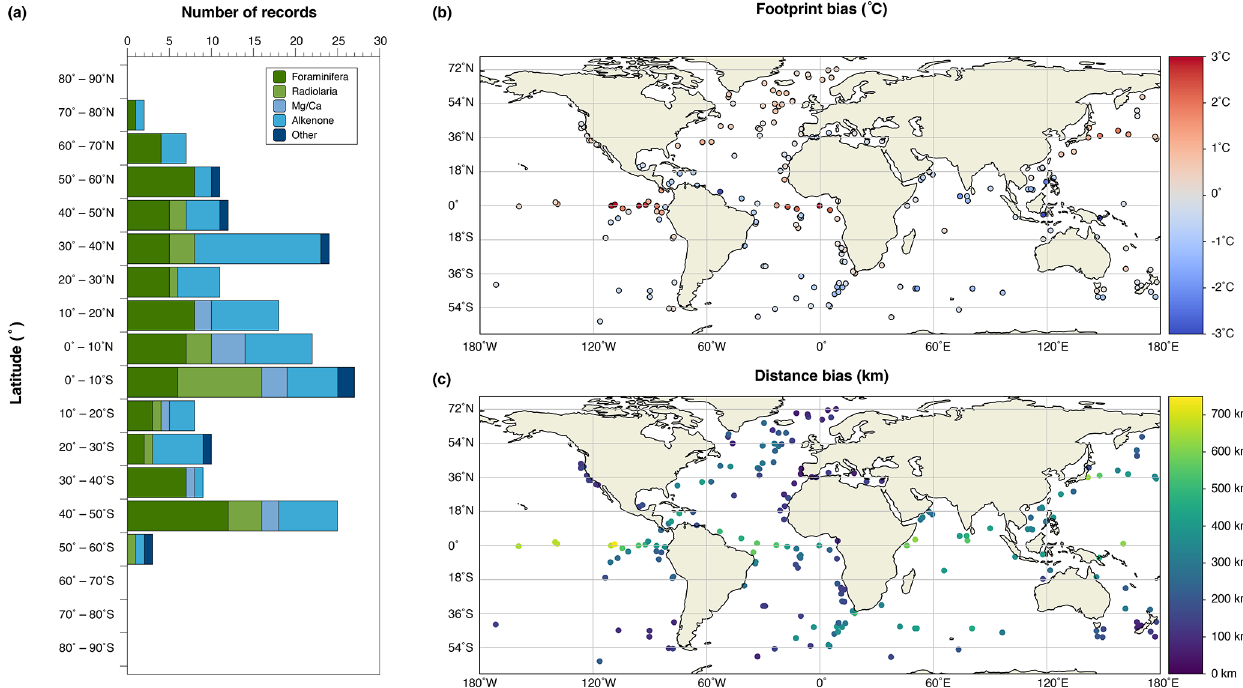
Figure 1. Last Interglacial proxy-based annual sea surface temperature dataset and modelled inherited signal. Histogram showing the number of Last Interglacial records of annual sea surface temperature binned by 10 ◦ latitude (a) with virtual microfossil temperature offsets defined as the difference between along-trajectory recorded temperatures and local temperatures (b) and distance (c) travelled in the Japanese Ocean model For the Earth Simulator (OFES; run between 1981 and 2010CE) determined for 30d “lifespans” of planktic organisms (van Sebille et al.,